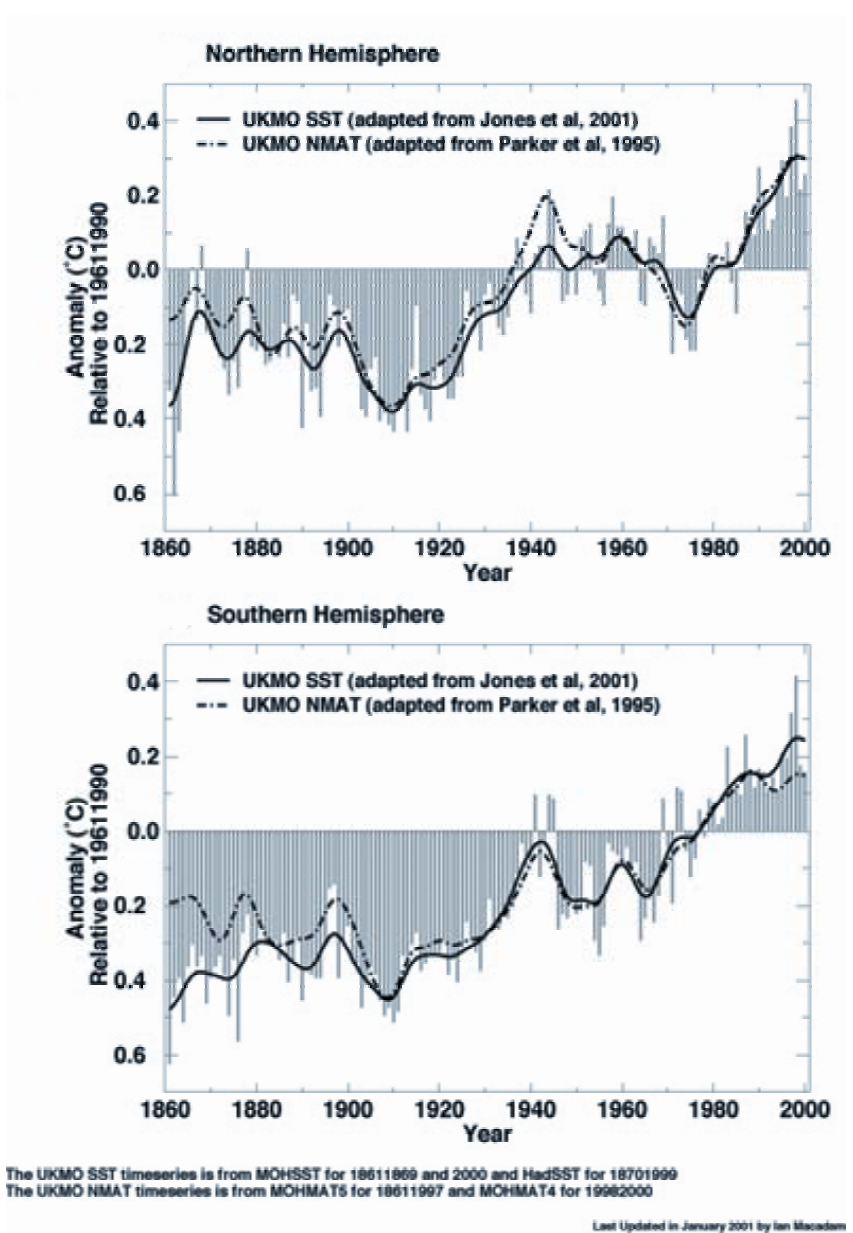
FIGURE 4. Comparison of sea surface temperatures (SST) with nighttime marine air temperatures (NMAT). Since NMAT measurements are difficult to obtain, SST are commonly used as proxies. Note recent disagreement 1990–2000 in the SH. (From Folland, C.K. et al. (2001) Global temperature change and its uncertainties since 1861, Geophys. Res. Lett., 28, 2621–2624. With